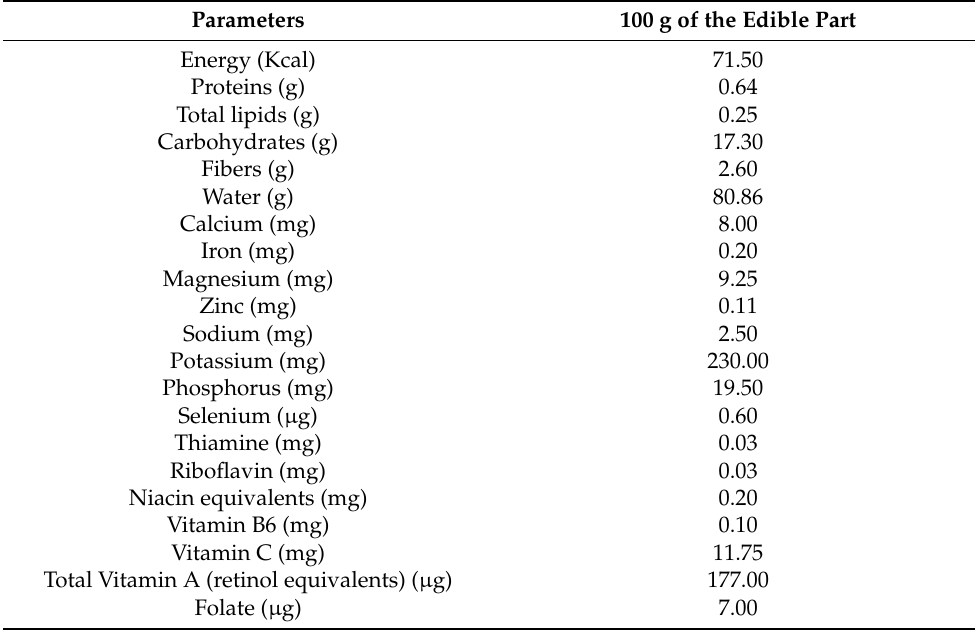
Table 1. Generic nutritional composition of persimmon [34,35].